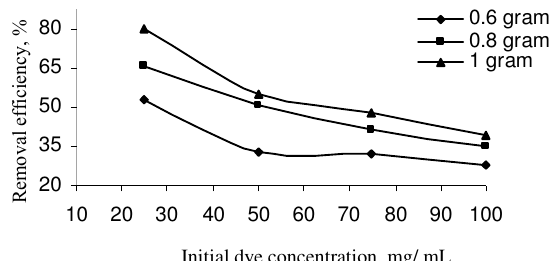
Figure 4. Effect of initial dye concentration on dye removal (pH=7, contact time =1 h).